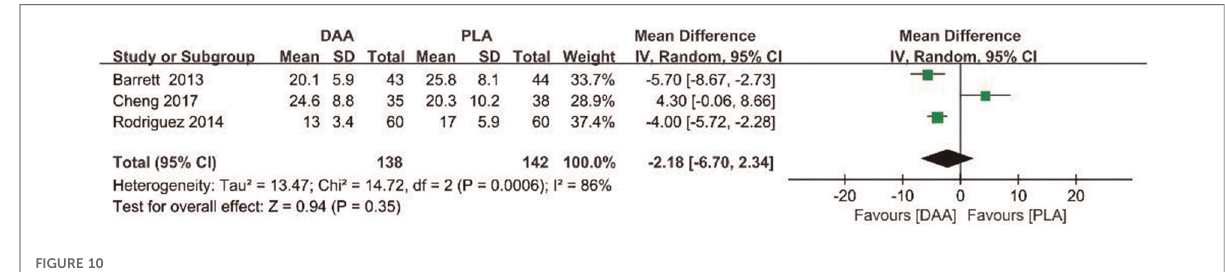
FIGURE 10 Acetabular anteversion outcome forest plot